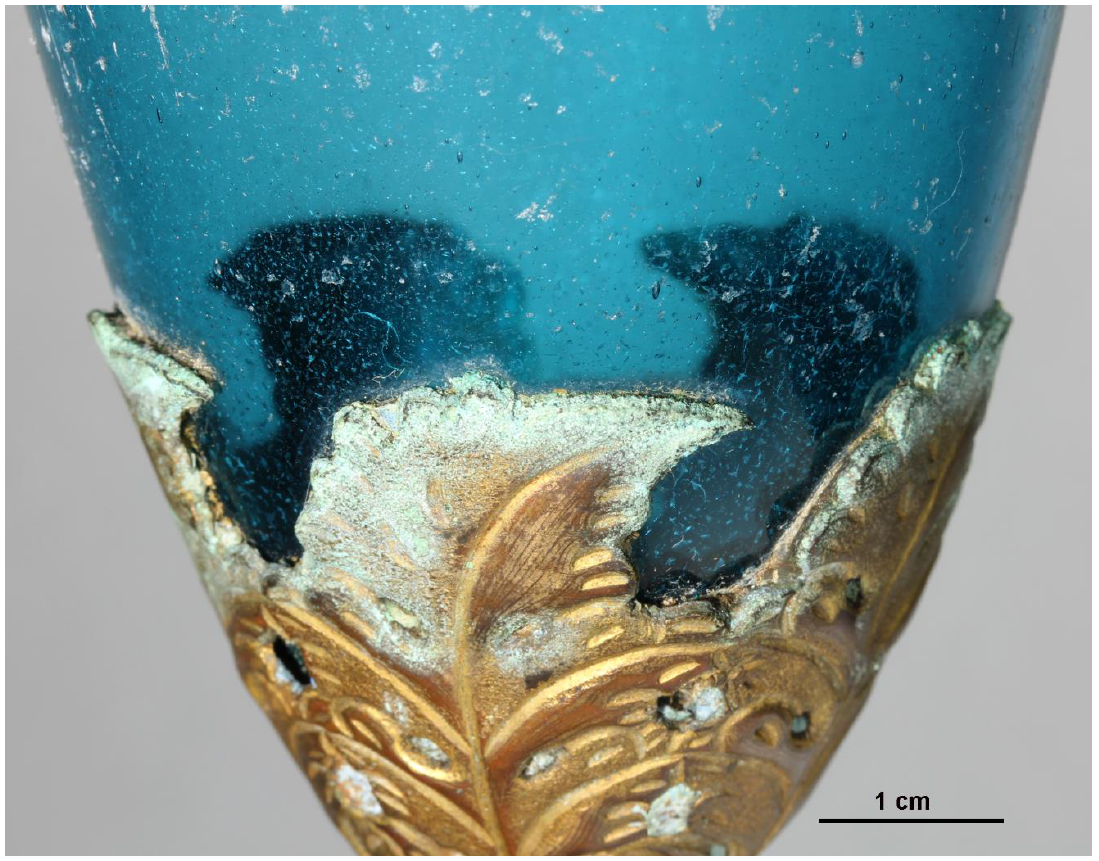
Figure 6. Corrosion of a blue bowl with gilt brass base, mid-nineteenth century, Kunstsammlungen der Veste Coburg, acc. no. HA 557.